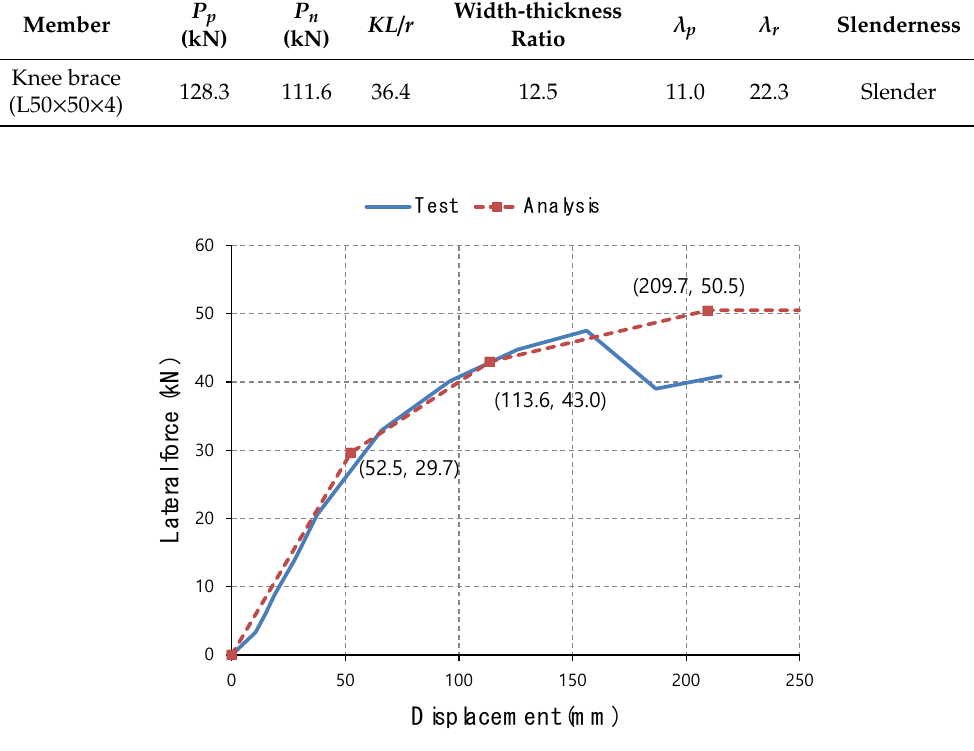
Figure 24. Validation of the analysis model for IC_OB_F specimen.